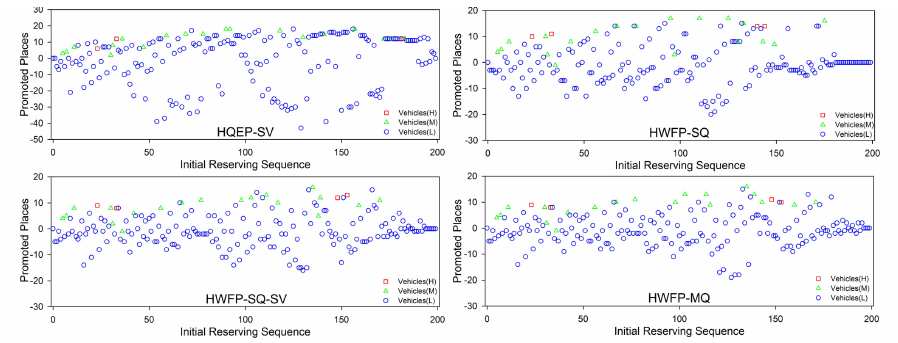
Figure 9. Comparison of Passing-through Orders of Four FAFP-based Policies: λ = 0.15, p υ . l = 4.5 m = 30%, p H = 5%, p M = 10%, p L = 85%, d a = 8 m, d r = 30 m, v m = 10 m/s, v r = 6 m/s, v γ = 8 m/s, N = 2.